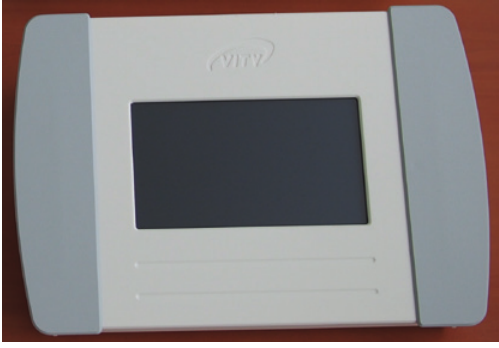
Figure 3: ASIM SMM Server Hardware Prototype